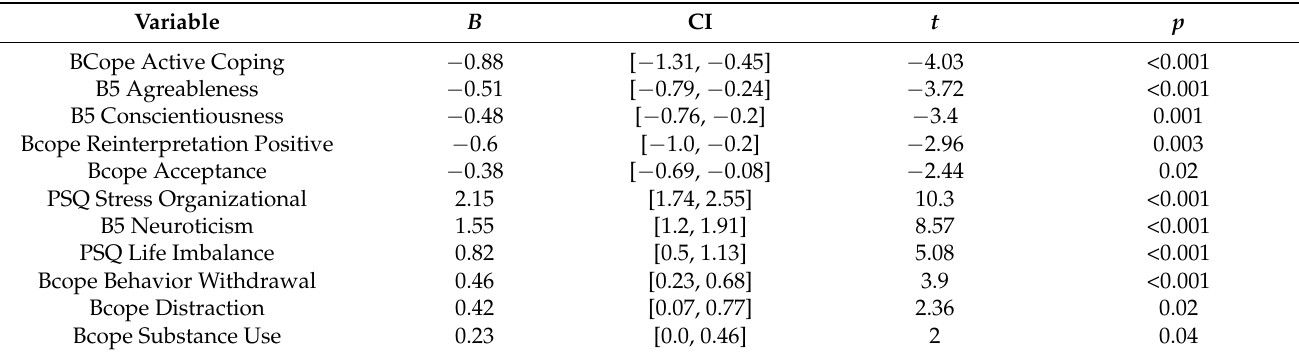
Table 4. Logistic regression results for the prediction of BO pathology presence (as determined by the MBI